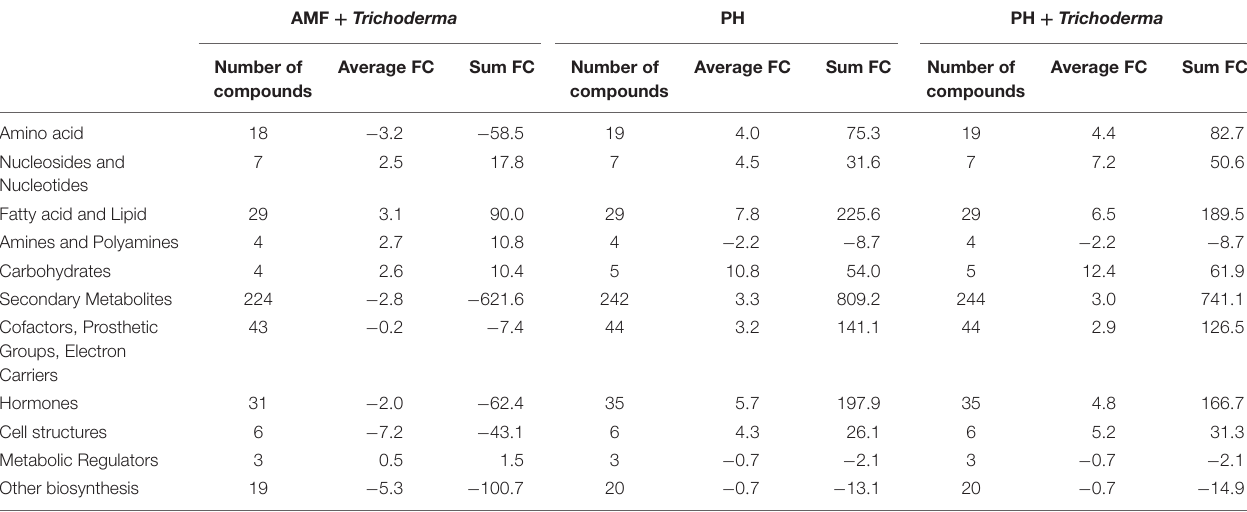
TABLE 3 | Summarized biosynthesis processes highlighted in roots of maize plants treated with a consortium of arbuscular mycorrhizal fungi (AMF), Trichoderma koningii TK7, and rhizosphere bacteria or with a consortium of Trichoderma koningii TK7 and rhizosphere bacteria (Tricho) plus a protein hydrolyzate-based biostimulant (PH), or with a protein hydrolyzate-based biostimulant